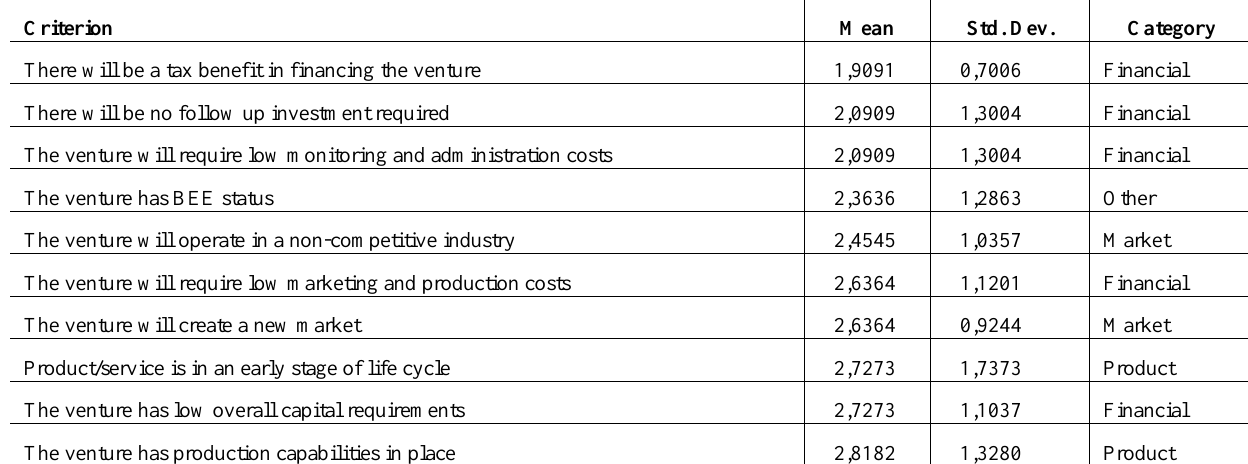
Table 4: Criteria rated as not important by participating VCs